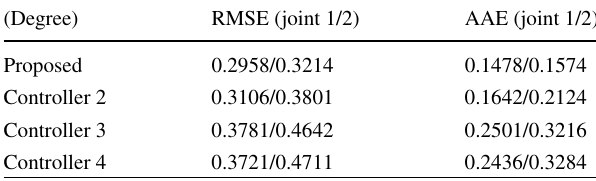
Fig. 9 Control torque curve Table 1 Comparison of tracking error RMSE values and AAE